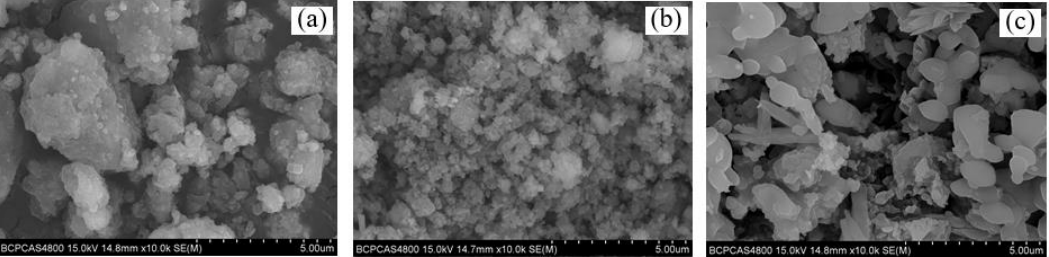
Figure 7. SEM images of the Shandong red mud—( a ) 4 mol / L HCl solution, ( b ) untreated, and ( c ) 4 mol / L NaOH solution.